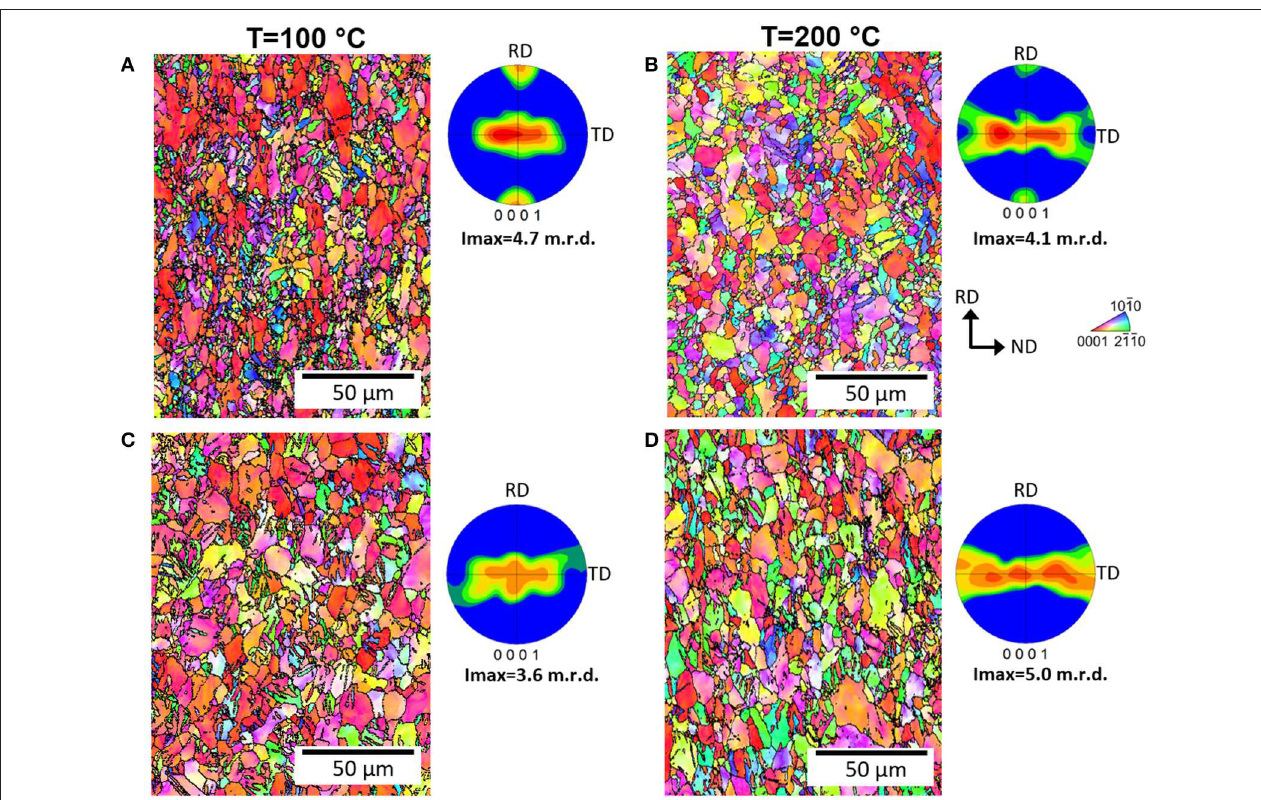
FIGURE 7 | EBSD orientation maps at the cup walls of (A) hot rolled and annealed ZEW200 alloy deep drawn at 100 ◦ C, (B) hot rolled and annealed ZEW200 alloy deformed at 200 ◦ C, (C) annealed ZXK alloy deformed at 100 ◦ C and (D) annealed ZXK alloy deformed at 200 ◦ C. Approximate positions of the EBSD measurements are indicated by dotted squares in Figure 5